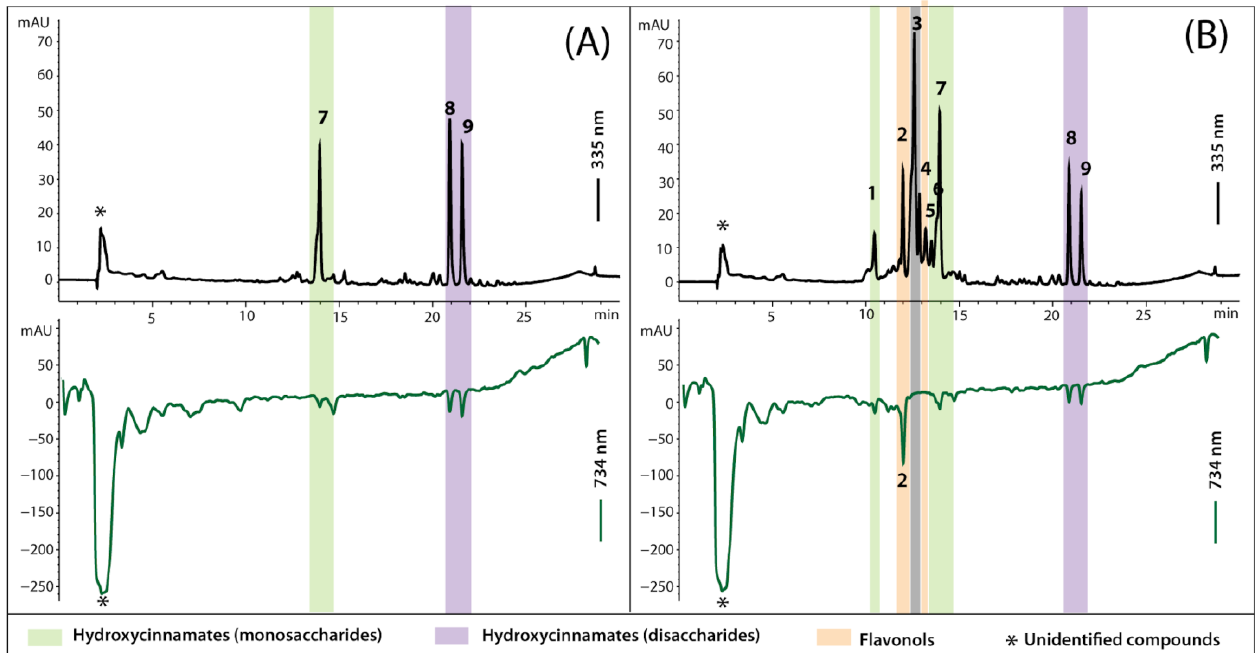
Figure 2. Chromatograms of crude cabbage extracts with ( A ) the lowest (non-treated leaves from cold storage in darkness) and ( B ) the highest (UV high in PAR) content of phenolics, detected at 335 nm set with profiles of antioxidants detected on-line after derivatisation with ABTS reagent and traced at 734 nm. The identity of peaks is given in Table 2.